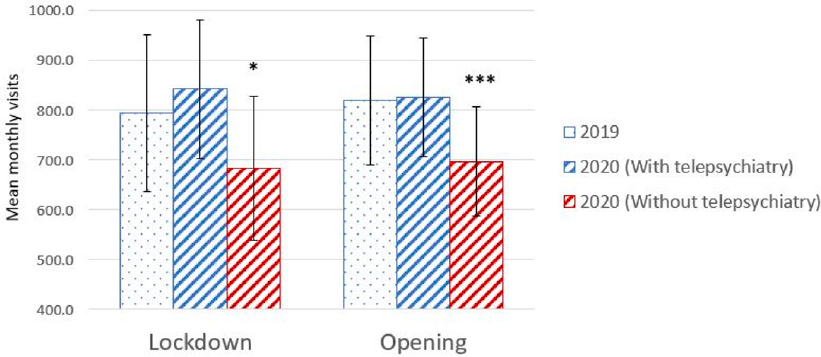
Figure 3. Monthly visits during the lockdown and opening periods in 2019 as compared to 2020. Bars relate to standard deviation. * p < 0.05, *** p < 0.001.